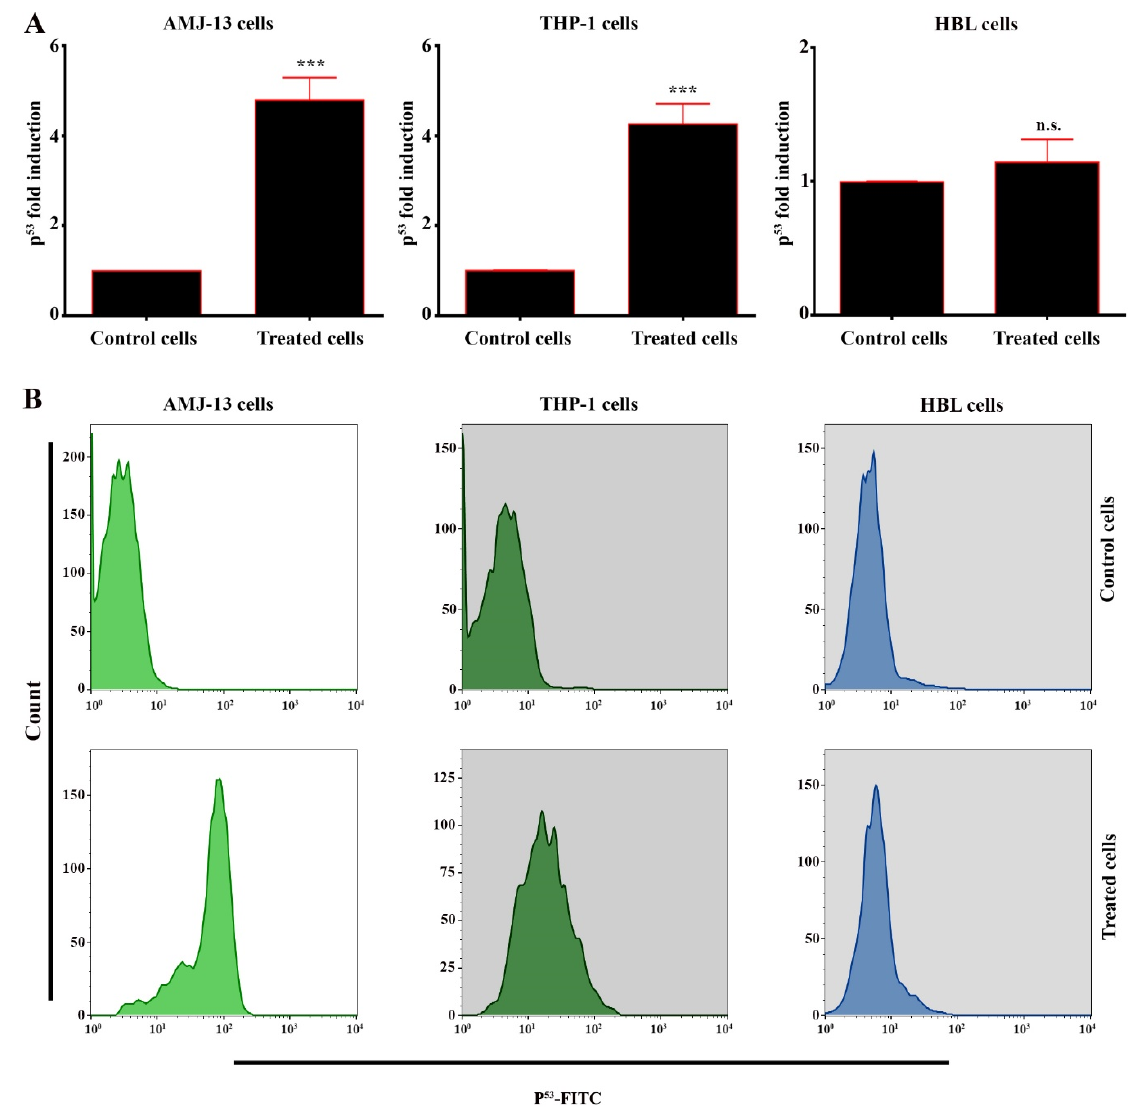
Figure 7. AgNPs upregulate p53 expression in AMJ-13 and THP-1 cells. ( A ) Cells were left untreated or treated with AgNPs at IC 50 (17.34 µ gmL − 1 ) for 24 h. Asterisks indicate statistically significant difference from untreated cells. ( B ) Represented Flow cytometry data in cells treated with AgNPs as in ( A ). Results are represented as mean ± SD.*** p < 0.001, ns: Non-significant.